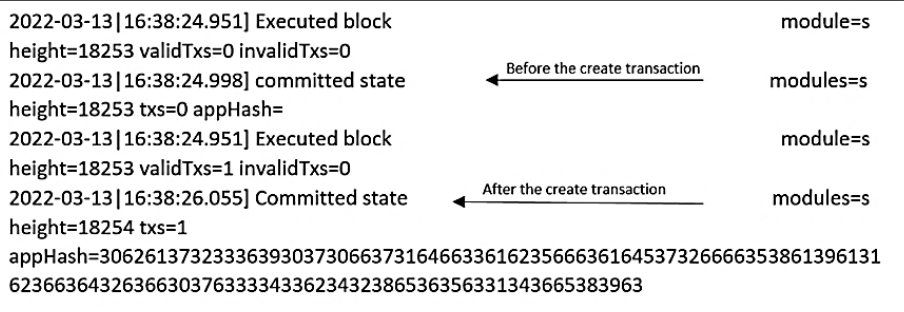
Figure 14. Block Creation.